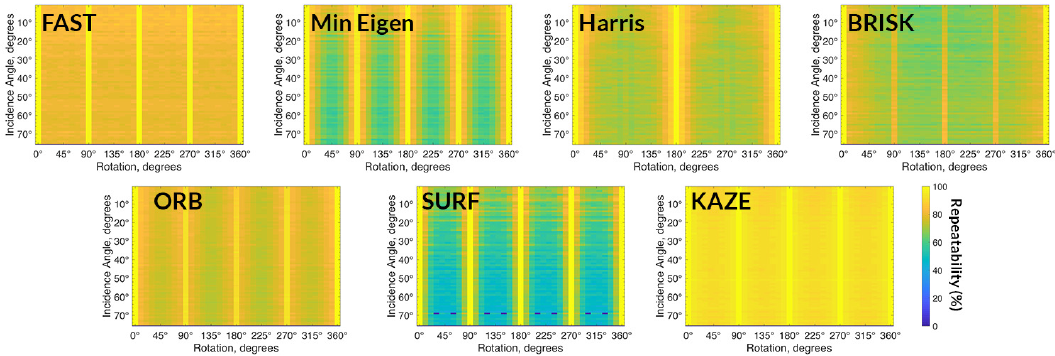
Figure 3. Repeatability of detection when the image is